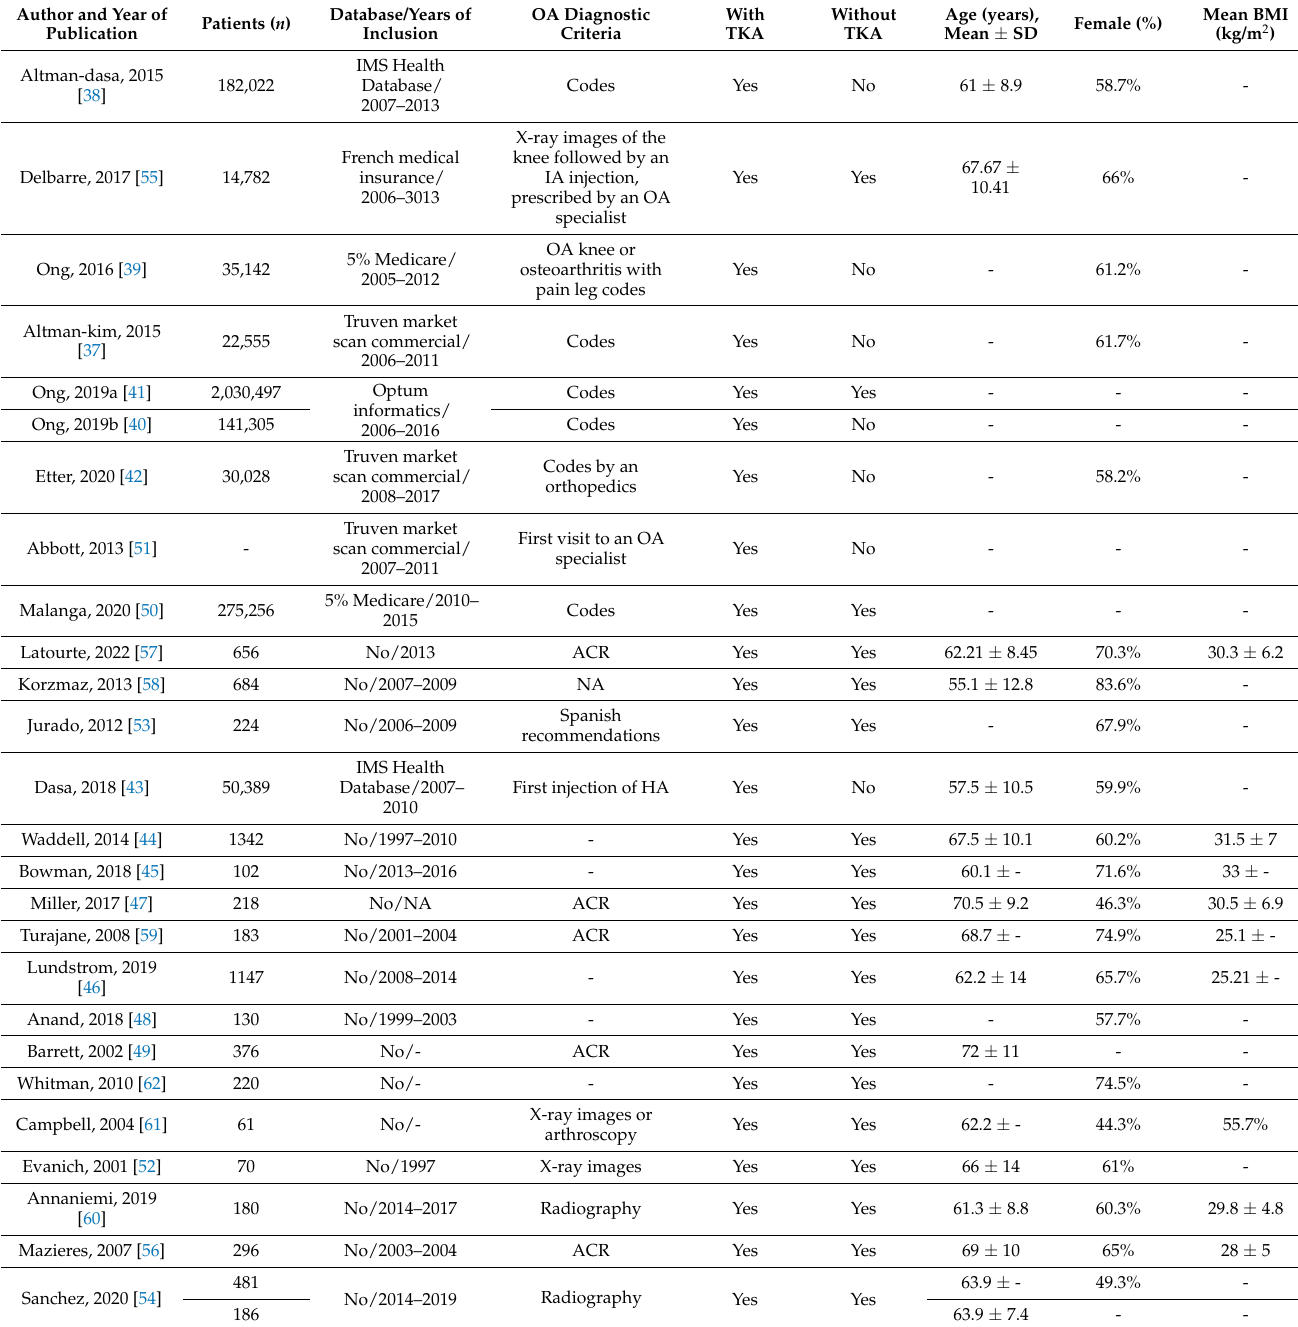
Table 2. Characteristics of studies and included